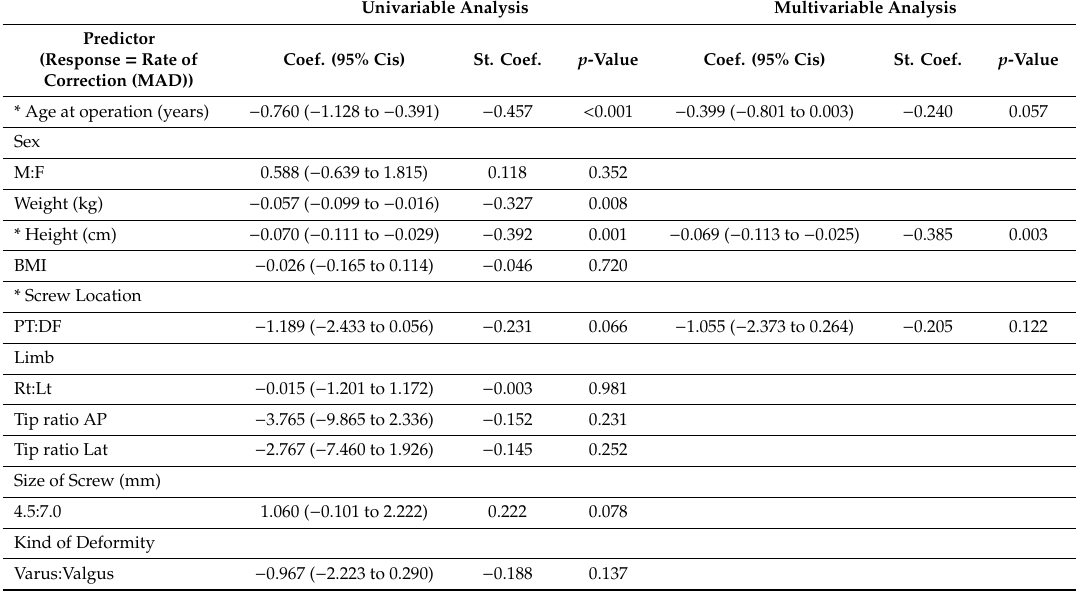
Table 5. Results of univariable and multivariable linear regression analysis using the correction rate (MAD) as a